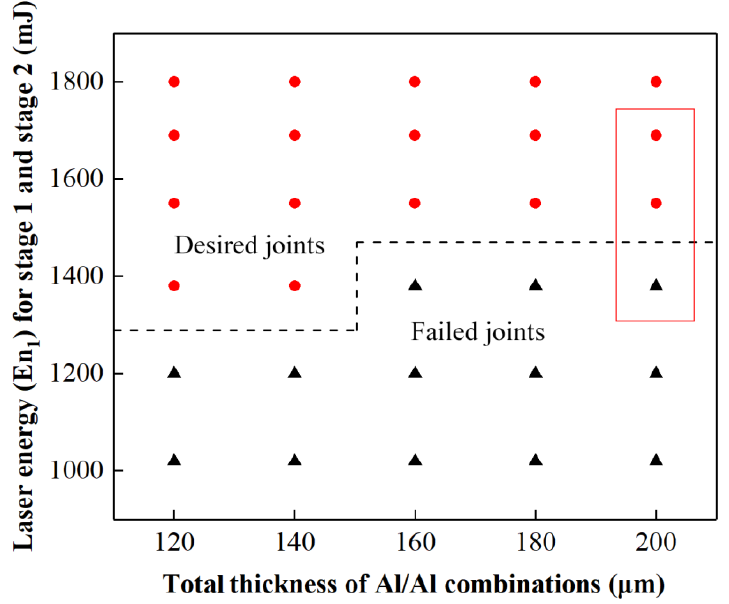
Figure 19. Process window of Total thickness with En 1 for Al/Al combinations.